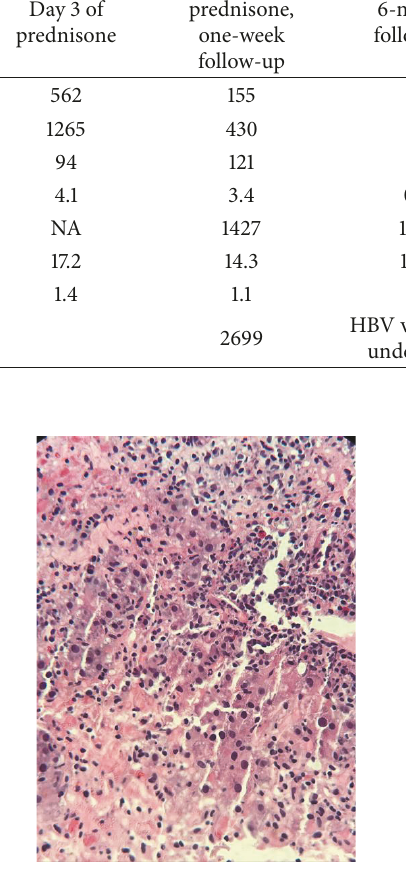
Figure 1: H&E stain of liver biopsy at high power. Liver Biopsy Pathology Report . Prominent lymphoplasmacytic infiltrate in the portal tracts with marked interface activity and multiple areas of hepatic necrosis. In some foci, plasma cells are particularly prom-